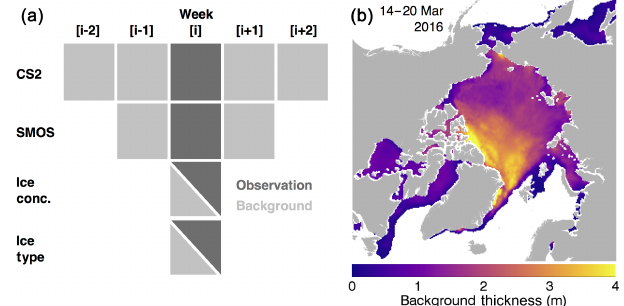
Figure 6. (a) The scheme illustrates how the background field and the observation field are generated from weekly input grids. Week [i] represents the target week. (b) Typical interpolated and low-pass- filtered background field as it is used for the optimal